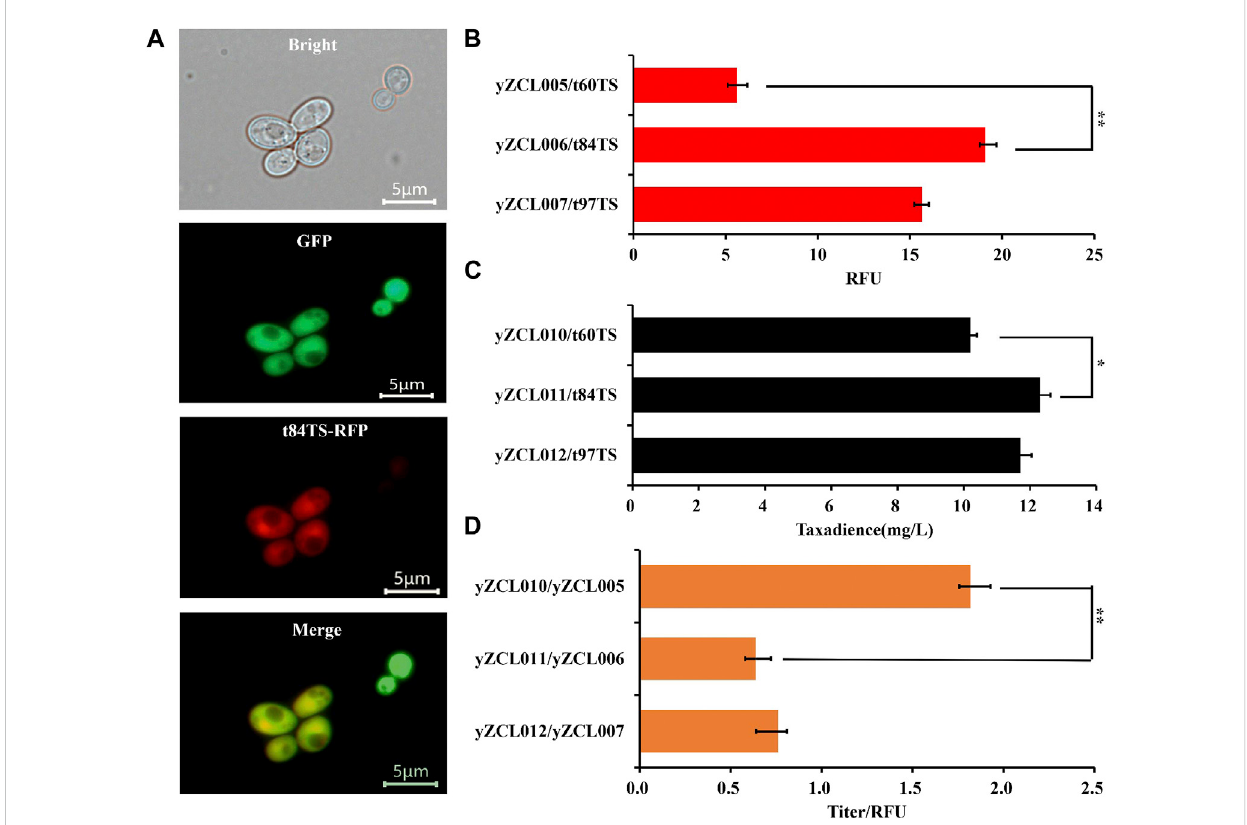
FIGURE 3 EffectofN-terminaltruncationonsubcellularlocalizationandperformanceofTSin S.cerevisiae . (A) Subcellularlocalizationoft84TSin S.cerevisiae . (B) Effect of N-terminal truncation on the expression of TS. (C) Effect of N-terminal truncation of TS on the yield of taxadiene. (D) Effect of N-terminal truncation on unit enzyme activity of TS. The error bars represent the means ± SD from three biological replicates. **p < 0.01, *p < 0.05, student ’ s t